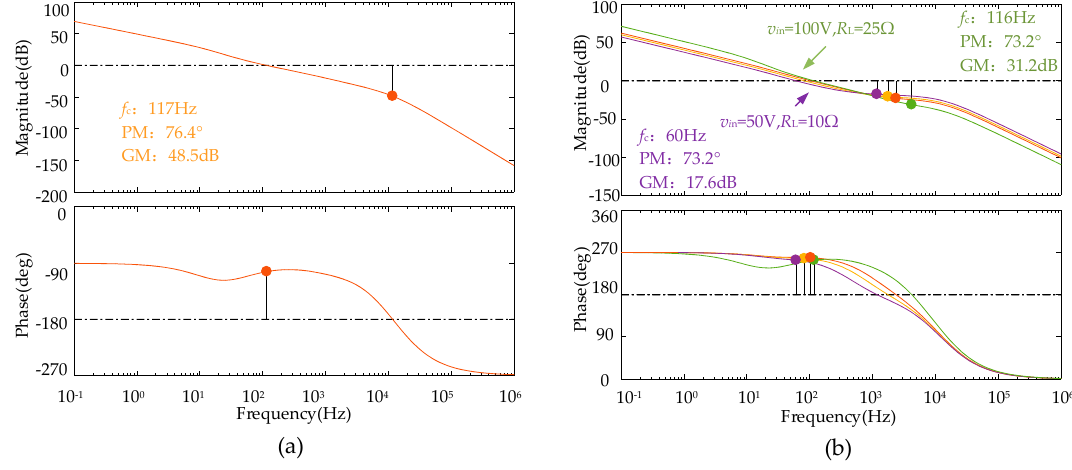
Figure 5. The Bode plots of the closed loop voltage control: ( a ) buck mode and ( b ) boost mode.